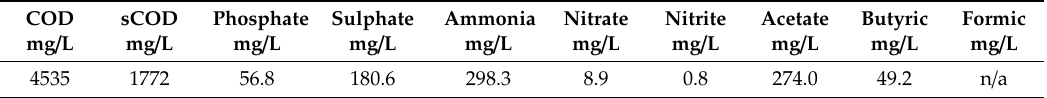
Table 1. Full wastewater components measured on a spot sample of return sludge liquor (RSL) taken prior to running the reactors on